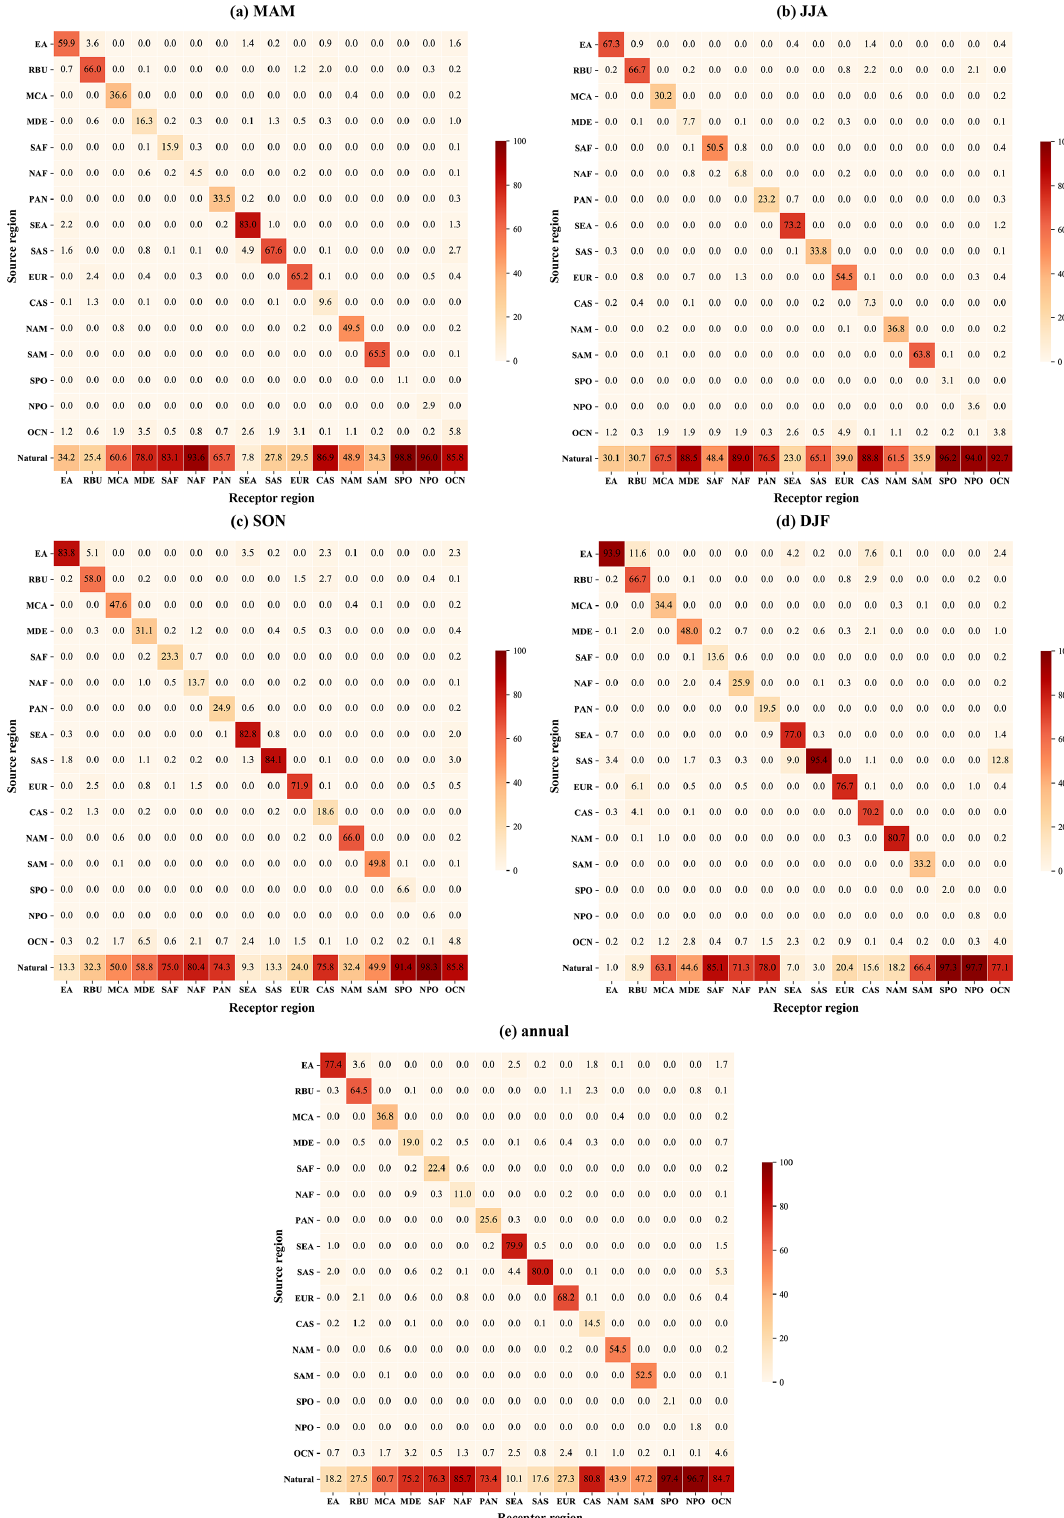
Figure 13. Annual and seasonal estimates of the contributions to surface PM 2 . 5 (%) from source regions to receptor